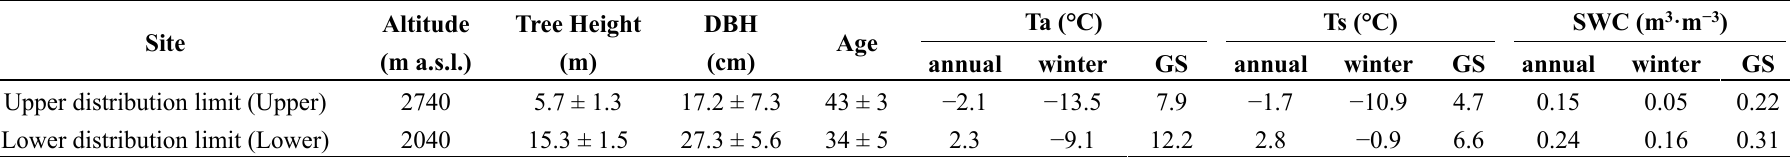
Table 1. Characteristics of Larix principis-rupprechtii trees ( n = 3 trees/site) and meteorological parameters recorded at the upper and lower distribution limits forest site in the year of